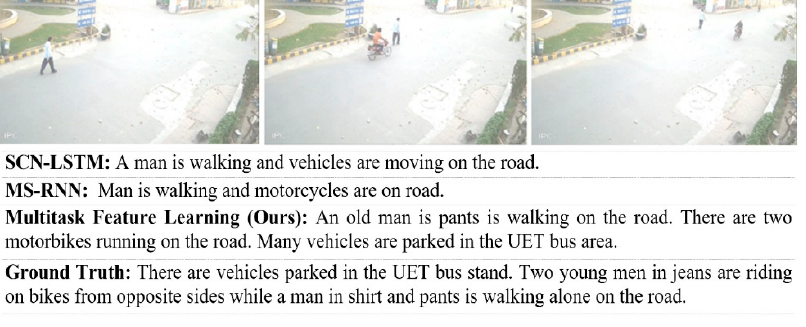
Figure 3. UET parking area.